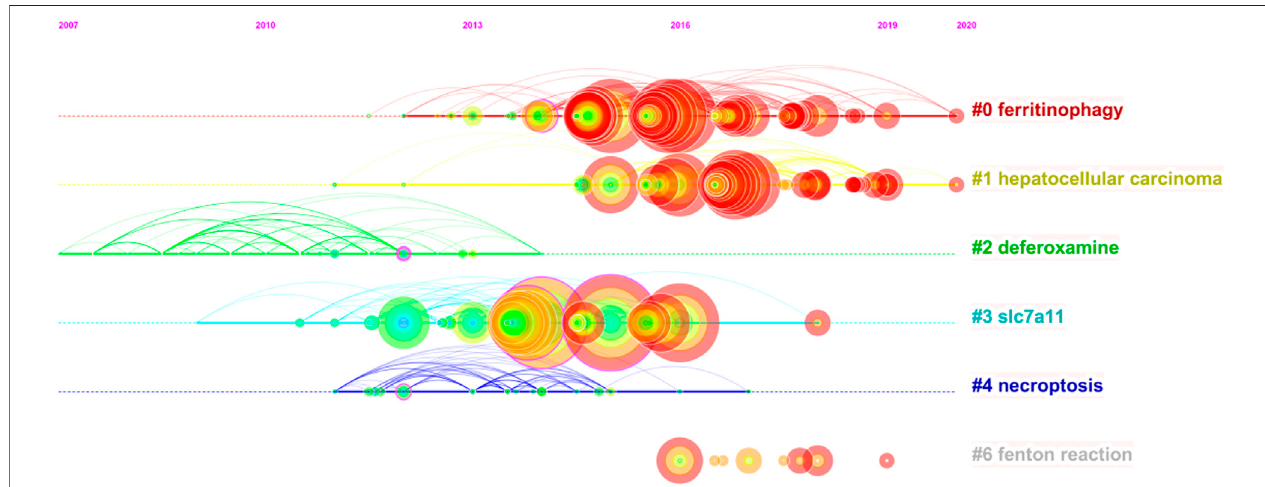
FIGURE 5 | Timeline view of co-cited references related to ferroptosis in cancer research.